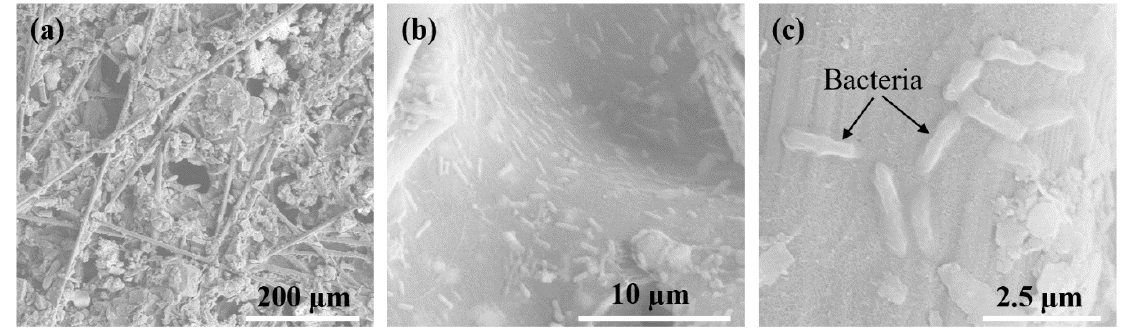
Figure 3. Scanning electron microscope (SEM) images of the surface of the anode electrode. ( a ) 150 × , ( b ) 4000 × , and ( c ) 12,000 × .